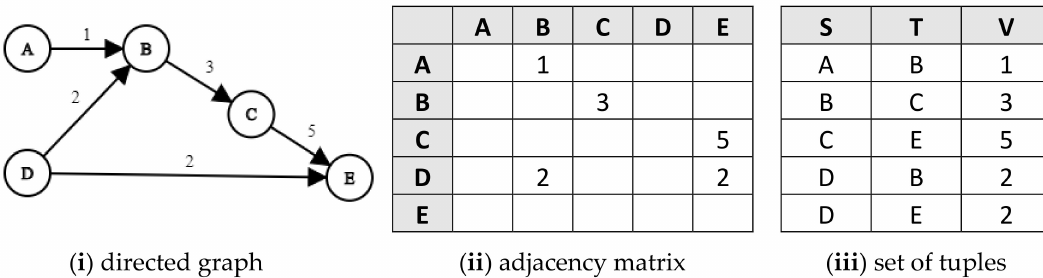
Figure 3. Equivalent representations of relations between pairs of objects as: ( i ) a digraph, ( ii ) an adjacency matrix (cell (r,c) holds the arrow value of row object (r) to column object (c), and ( iii ) a set of tuples (triplets of source object (S), target object (T), and value (V), relating S to